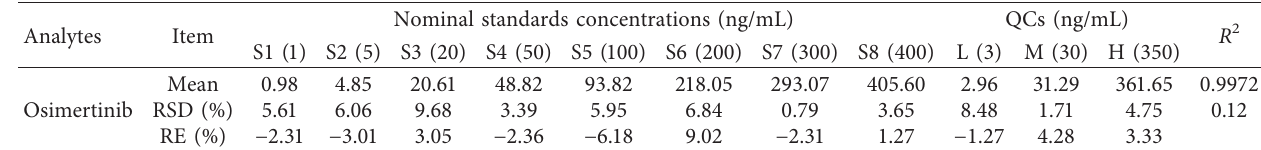
Figure 3: Typical MRM chromatograms of osimertinib and nilotinib (IS). (a) Blank plasma matrix sample; (b) blank plasma matrix sample spiked with the analytes (at medium concentrations); (c) real plasma sample obtained from rat after intravenous administration of Table 2: Calibration standards for osimertinib in rat plasma (linear weighted 1/ x 2 , n � 6).